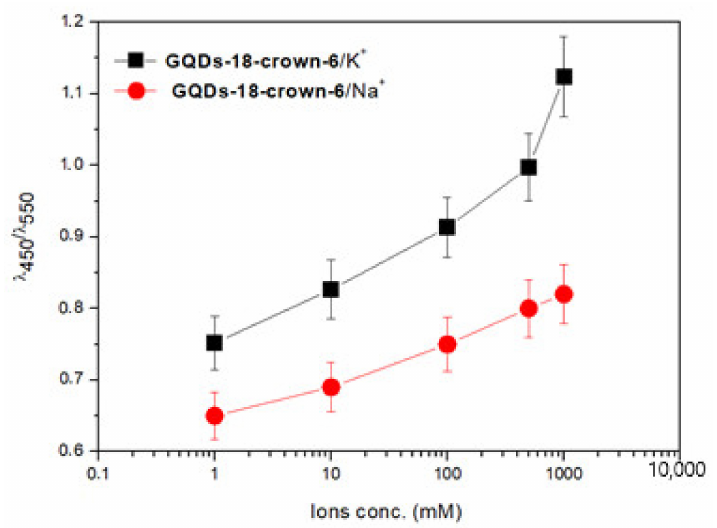
Figure 7. Ratio of fluorescence intensity (I 450 /I 550 ) for GQDs-18-crown-6 sample, measured as a function of the concentration of K + and Na + ions. Error bars indicate the standard deviation from experiments done in